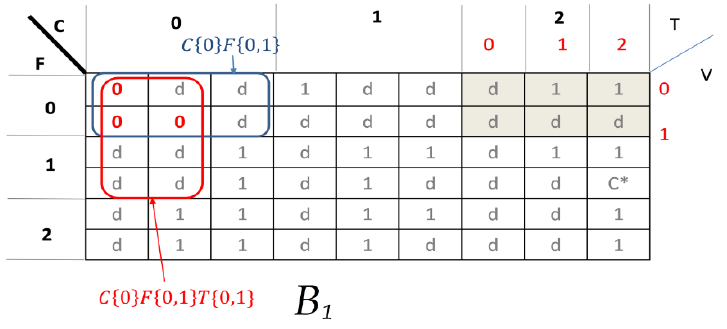
Fig. 6. A multi-valued-Karnaugh-map representation of 𝑩 (introduction of party bans), a translation of Table 3 in Hartmann and Kemmerzell (2010) with loops covering the negated part 𝑩